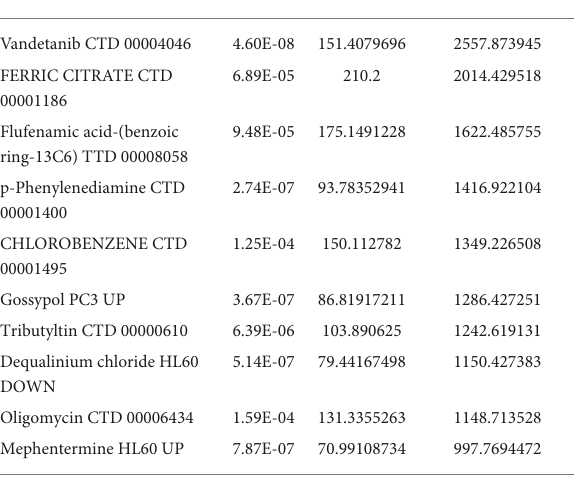
TABLE 3 Drug targets of 21 ferroptosis-related genes in IS. Term